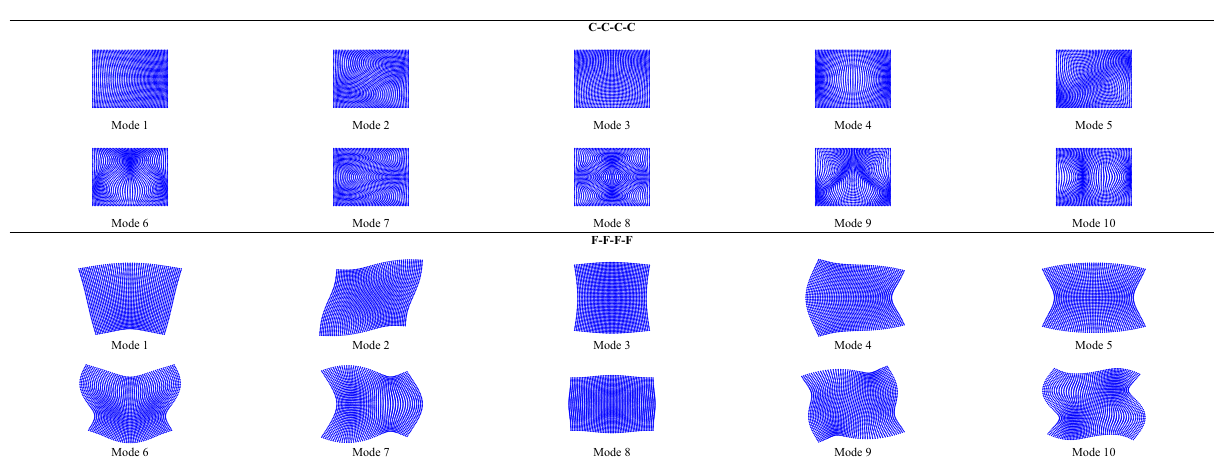
Figure 2. The first ten vibration modes of orthotropic square plates with E y